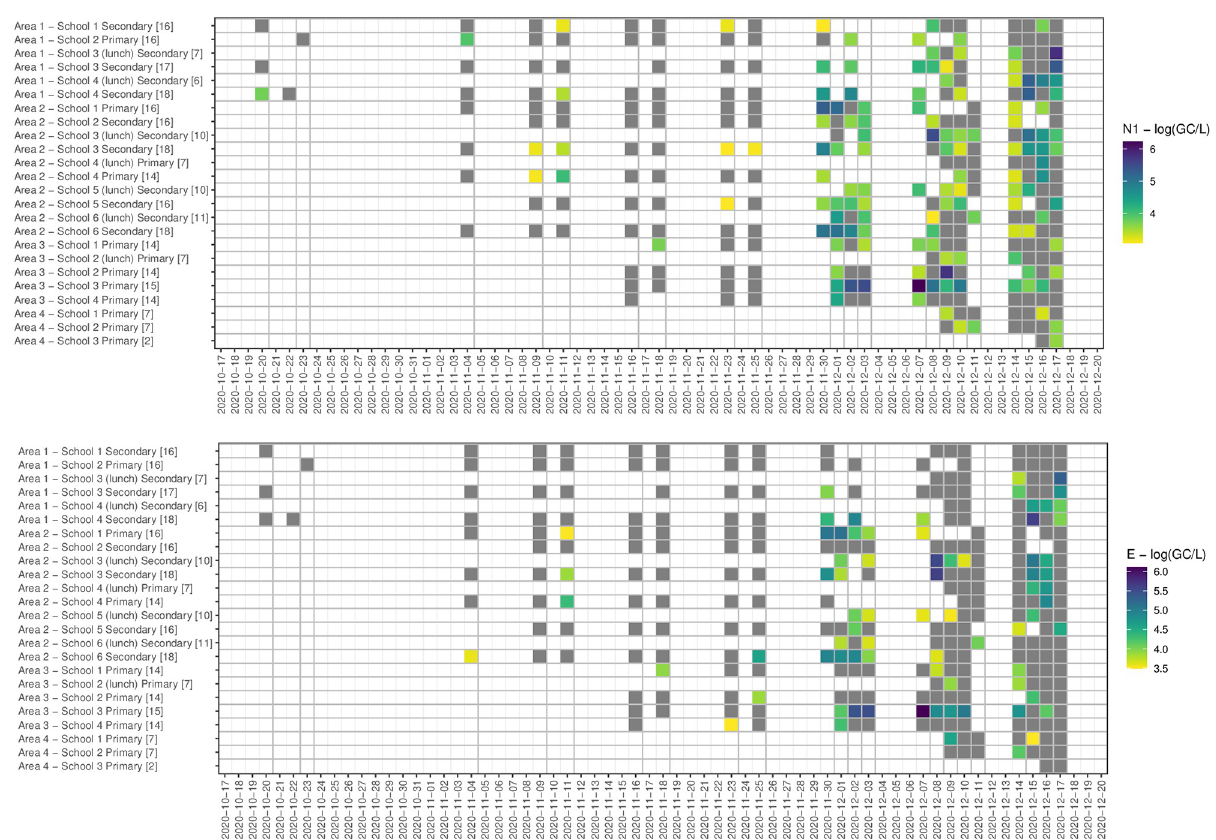
Fig 3. Heatmap daily log10(GC/L) N1 gene and E gene (grey indicated non-detection). Note: number of samples collected for each school/sample pattern is provided in square brackets at the end of the name of the school.